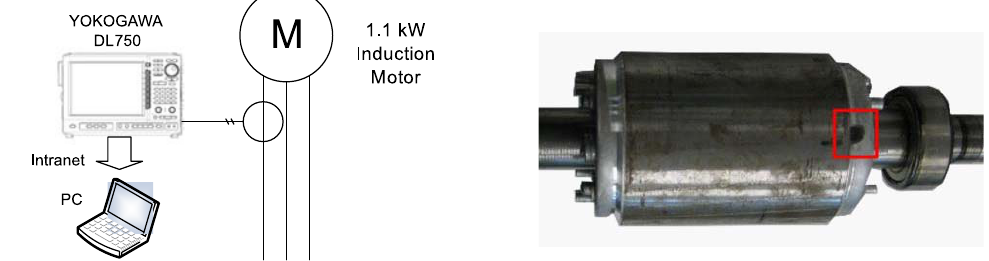
Figure 7. Experimental setup: measurement equipment ( left ); and rotor of the motor whose characteristics are given in Appendix A, with a broken bar ( right